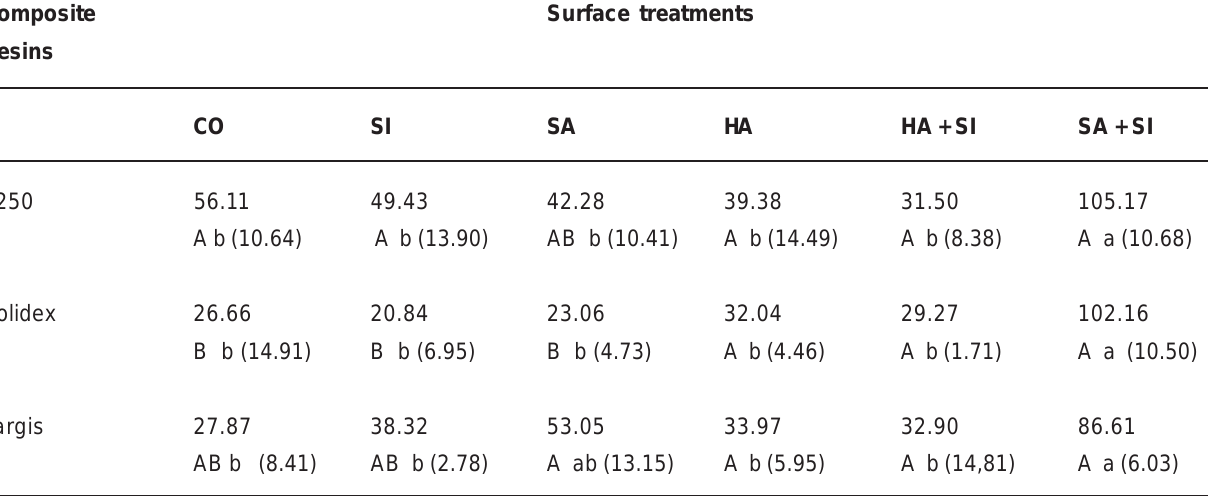
Groups that are not significantly different (p<0,05) are marked with the same letters (lower case – horizontal and capital letter -